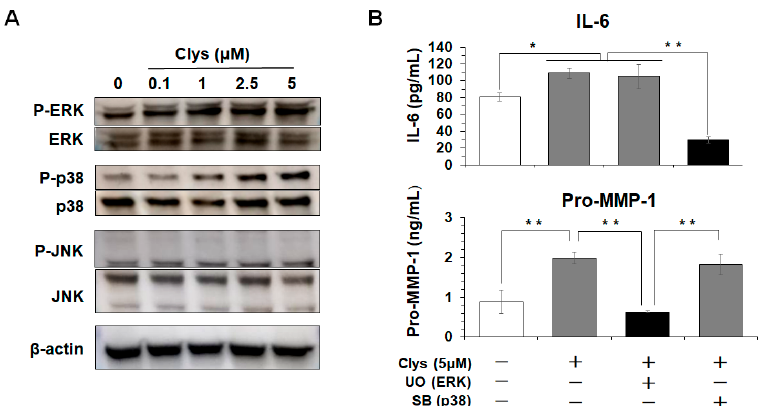
Figure 4. Candidalysisn (Clys)-induced intracellular signaling pathways, MAPKs, in human gingival fibroblasts (HGFs). ( A ) Phosphorylation levels of Clys-induced intracellular signaling pathways, MAPKs, in HGFs. HGFs were cultured with Clys (0.1, 1, 2.5, 5 μ M) for 30 min. Cell lysates were separated by sodium dodecyl sulfate-polyacrylamide gel electrophoresis (SDS-PAGE) and analyzed using Western blotting probed with antibodies against phospho-ERK/total-ERK, phospho-p38/total-p38 and phospho- c-Jun N-terminal kinase (JNK) /total-JNK as well as β -actin. ( B ) HGFs were pre-treated with U0126 (10 μ M), or SB2013580 (10 μ M) for 1 h and then treated with 5 μ M Clys for 24 h. Production levels of IL-6 and pro-MMP-1 in HGFs were quantified using ELISA. The production levels of IL-6 and pro-MMP-1 were significantly decreased by the p38-specific inhibitor SB2013580 and the ERK-specific inhibitor U0126, respectively (Black column). Values of ** p < 0.01 and * p < 0.05 were considered to indicate statistical significance (one-way analysis of variance with a post-hoc Tukey’s test).